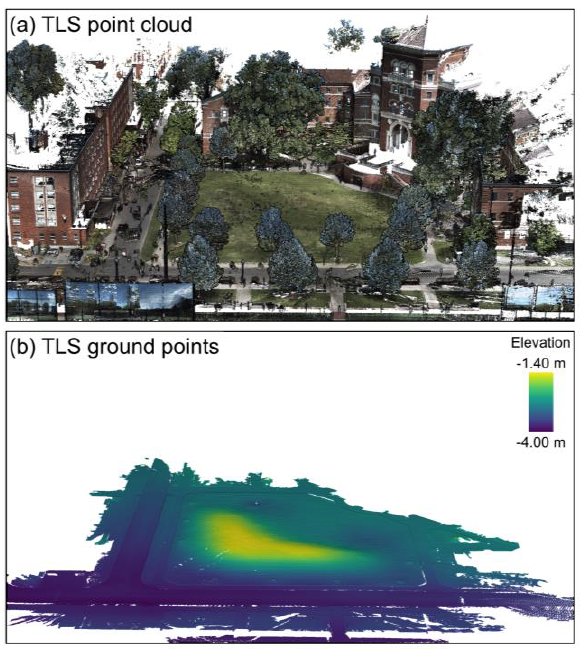
Figure 8 Vo-SmoG result ( VS Ground = 0.05 m) for the TLS point